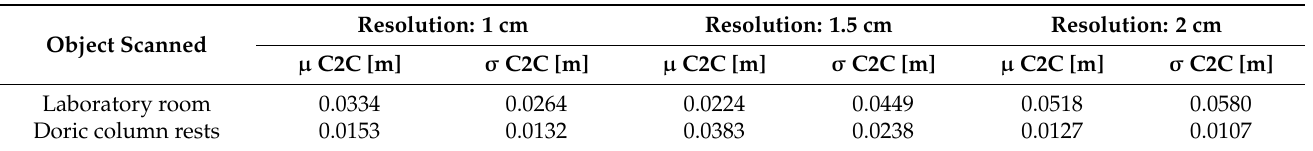
Table 7. Mean and standard deviation values of C2C distance obtained in the third and fourth case studies.